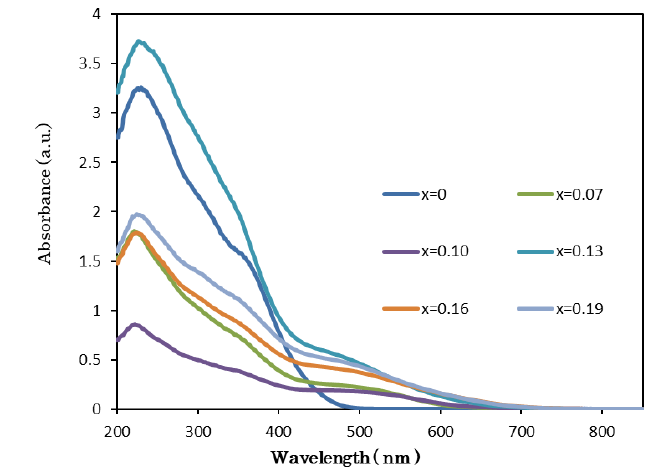
Figure 4. UV-visible spectra of Zn (1 − 2x) (CuGa) x In 2 S 4 .